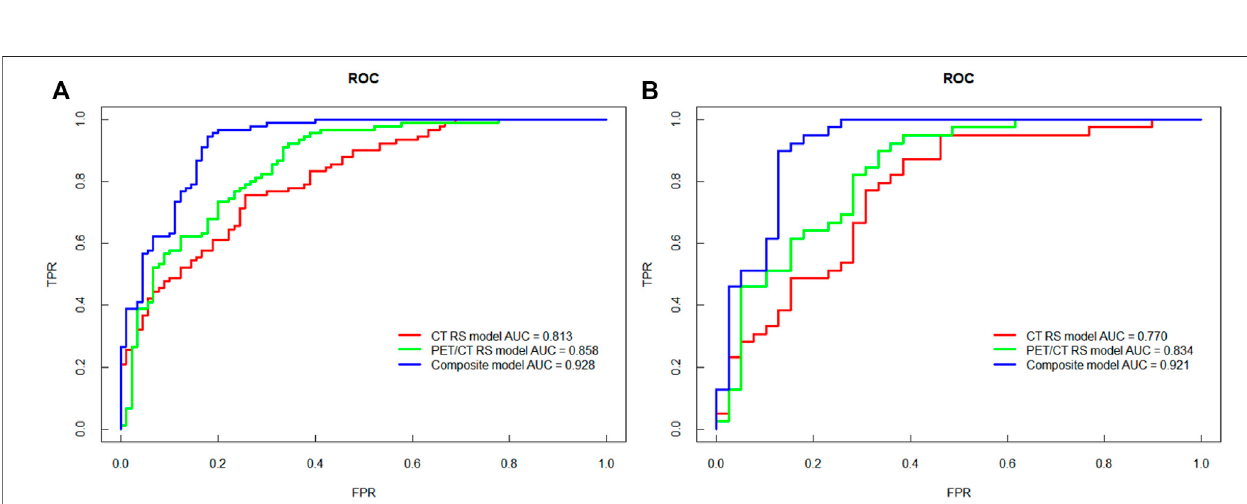
FIGURE 2 | The LASSO and 10-fold cross-validation were used to select the optimal radiomics features. 12 features corresponding to the optimal lambda values were selected. (A) Mean square error path. (B) LASSO coef fi cient pro fi les of radiomics features.